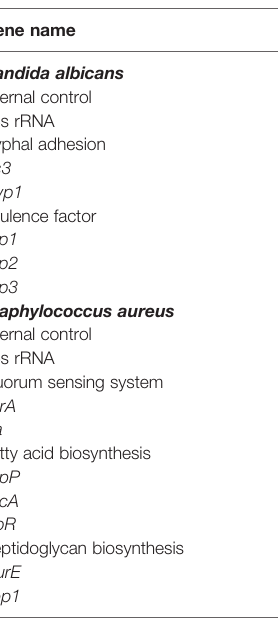
TABLE 1 | Primer sequences used in this study (5 ′ -3 ′ ).